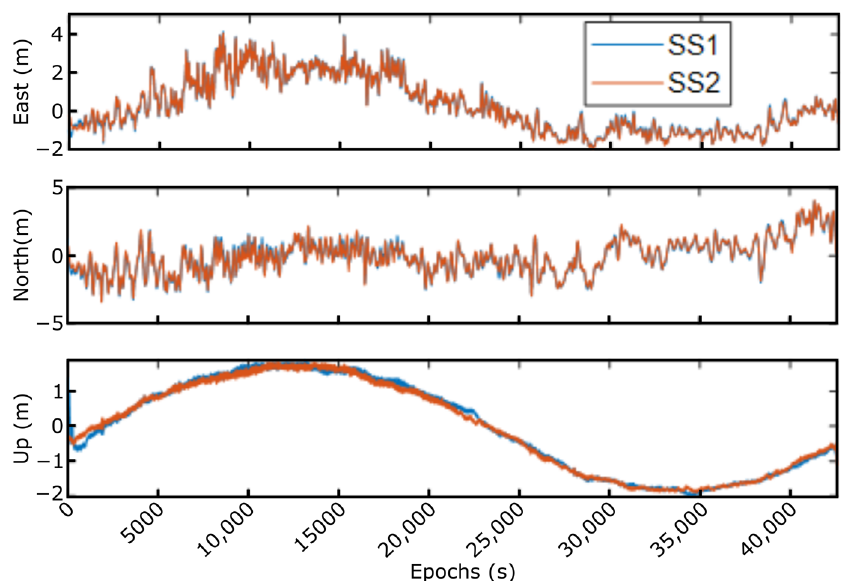
Figure 16. Test results in the HarshLab platform at the port.